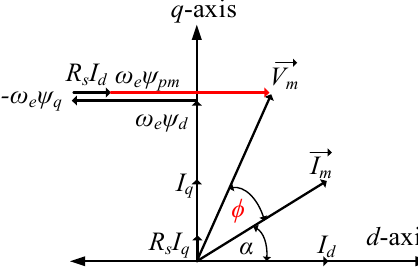
Figure 17. Vector diagram of PMaSynRM.